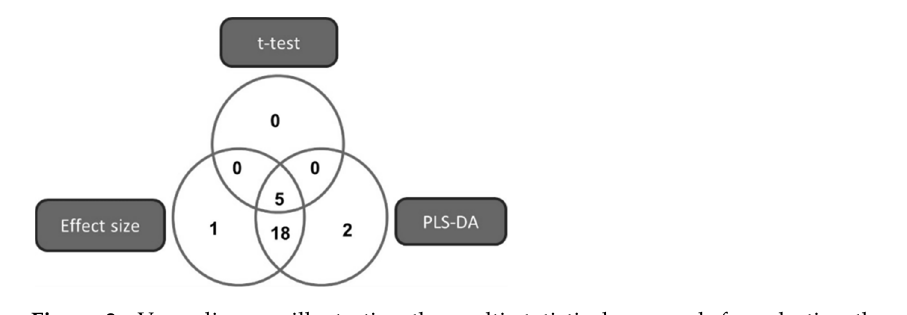
Figure 3. Venn diagram illustrating the multi-statistical approach for selecting the metabolites that best describe the variation detected in the metabolome of Mtb cultured with and without ciprofloxacin. The selected metabolite markers are listed according to their PLS-DA VIP values in Table 1, along with their respective average concentrations and univariate test outcomes. Of the total, 61.5% (16/26) of the markers were elevated; most of these were fatty acids. The most differentiating marker was malic acid, with an exceptionally high d-value of 6.621 and low p -value of > 0.0001. Table 1. Metabolite markers best describing the variance between the individually cultured Mtb samples in the absence ( Mtb controls) and presence of ciprofloxacin.